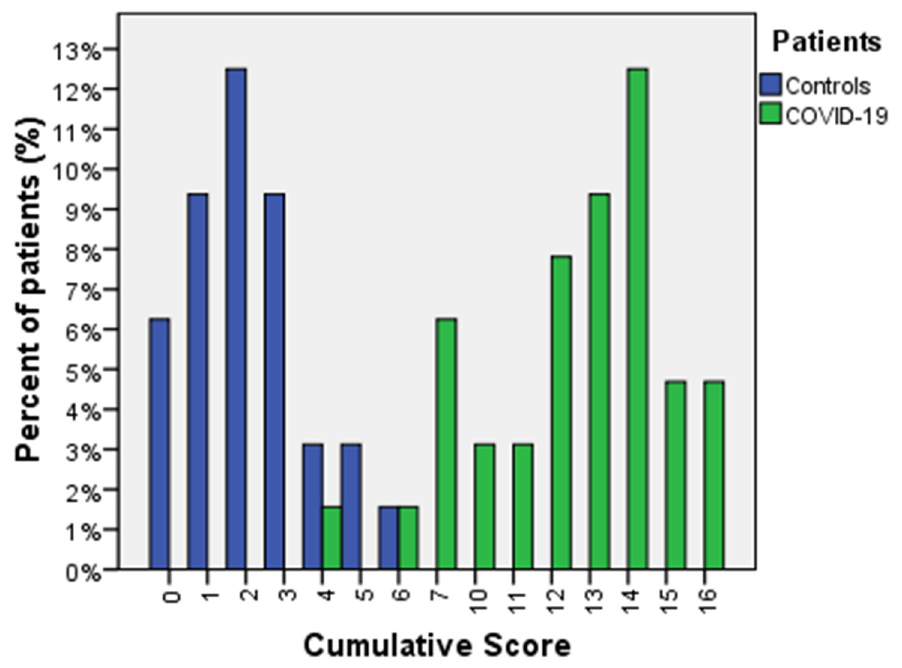
Figure 2. Cumulative score analysis: case-control distribution of values. Distribution of CS values between controls (green) and the COVID-19 population (blue): among controls, 13.8% had a CS of 0; 20.7% had a CS of 1; 27.6% had a CS of 2; 20.7% had a CS of 3; 6.9% had a CS of 4; 6.9% had a CS of 5; 3.4% had a CS of 6; no patient in the control group had values >6.5. Among the COVID-19 population: 2.9% had a CS of 4; 2.9% had a CS of 6; 11.4% had a CS of 7; 5.7% had a CS of 10; 5.7% had a CS of 11; 14.3% had a CS of 12; 17.1% had a CS of 13; 22.9% had a CS of 14; 8.6% had a CS of 15; 8.6% had a CS of 16. Less than 5% of COVID-19 patients had a CS < 6.5. To note, the CS threshold predicted SARS-COV-2 positivity in 100% of positive pa- tients (12/85) with a first (false negative) oro-nasopharyngeal RT-PCR result.